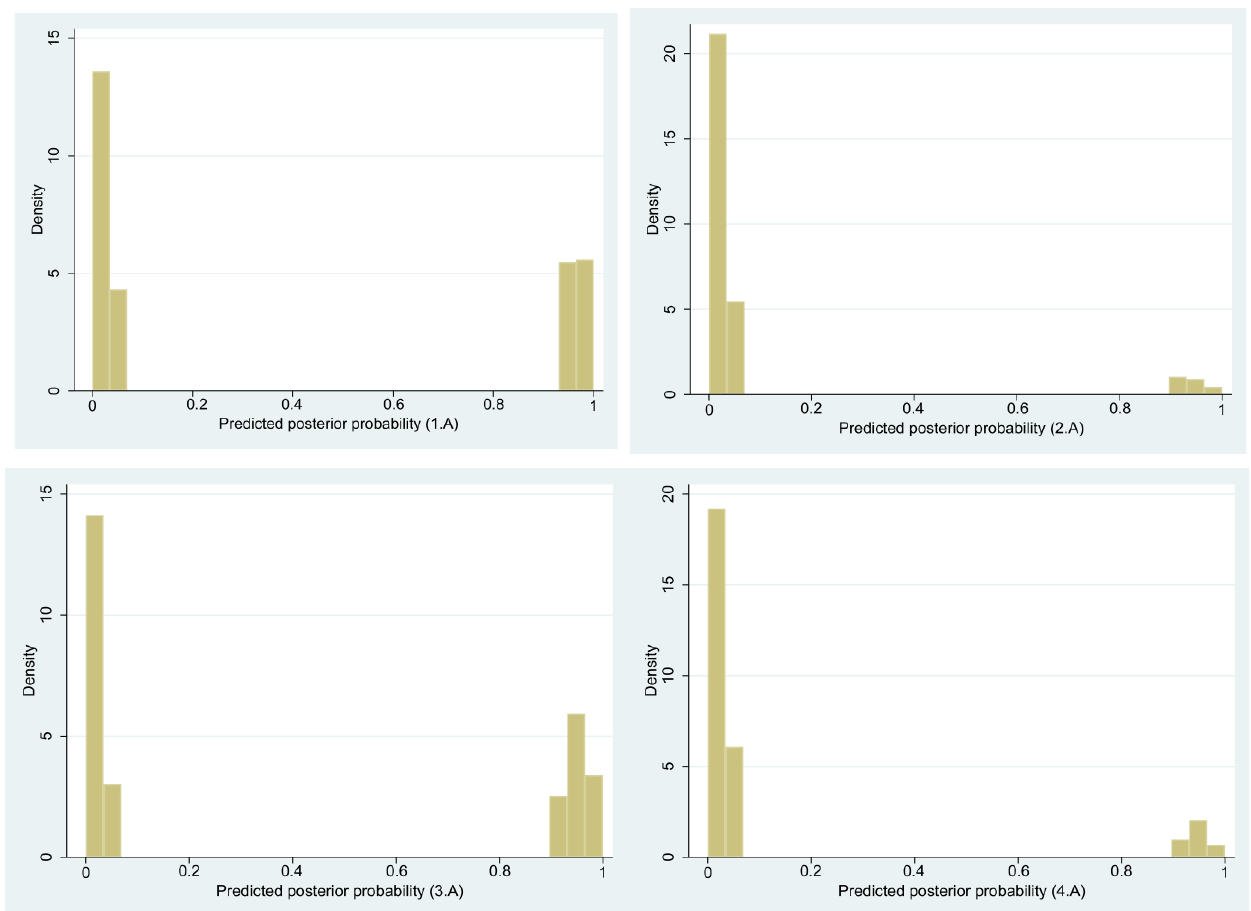
Figure 2. Bimodal distributions of the estimated probability of belonging to each latent class, from class 1 to class 4 (from 1.A to 4.A). N1 ( p > 0.5) = 340, N2 ( p > 0.5) = 73, N3 ( p > 0.5) = 364, N4 ( p > 0.5) = 114.